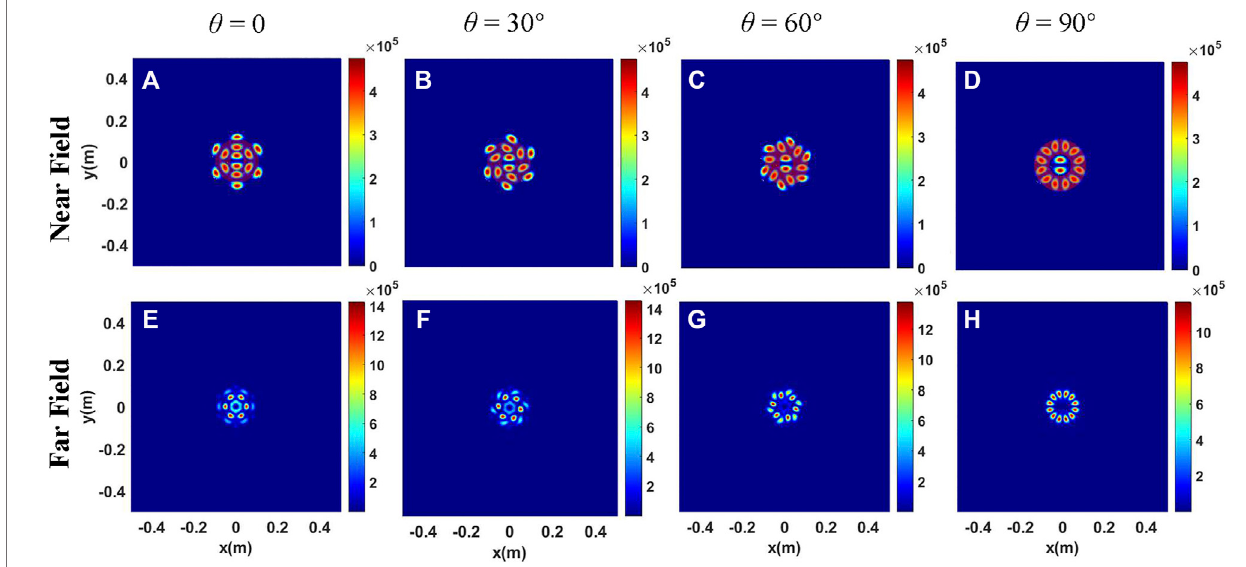
FIGURE 2 | Intensity distributions of the LP 11 mode beam array for different rotation angles of beamlets. (A – D) Intensity distributions at the initial plane. (E – H) Intensity distributions at the receiver plane in free space.